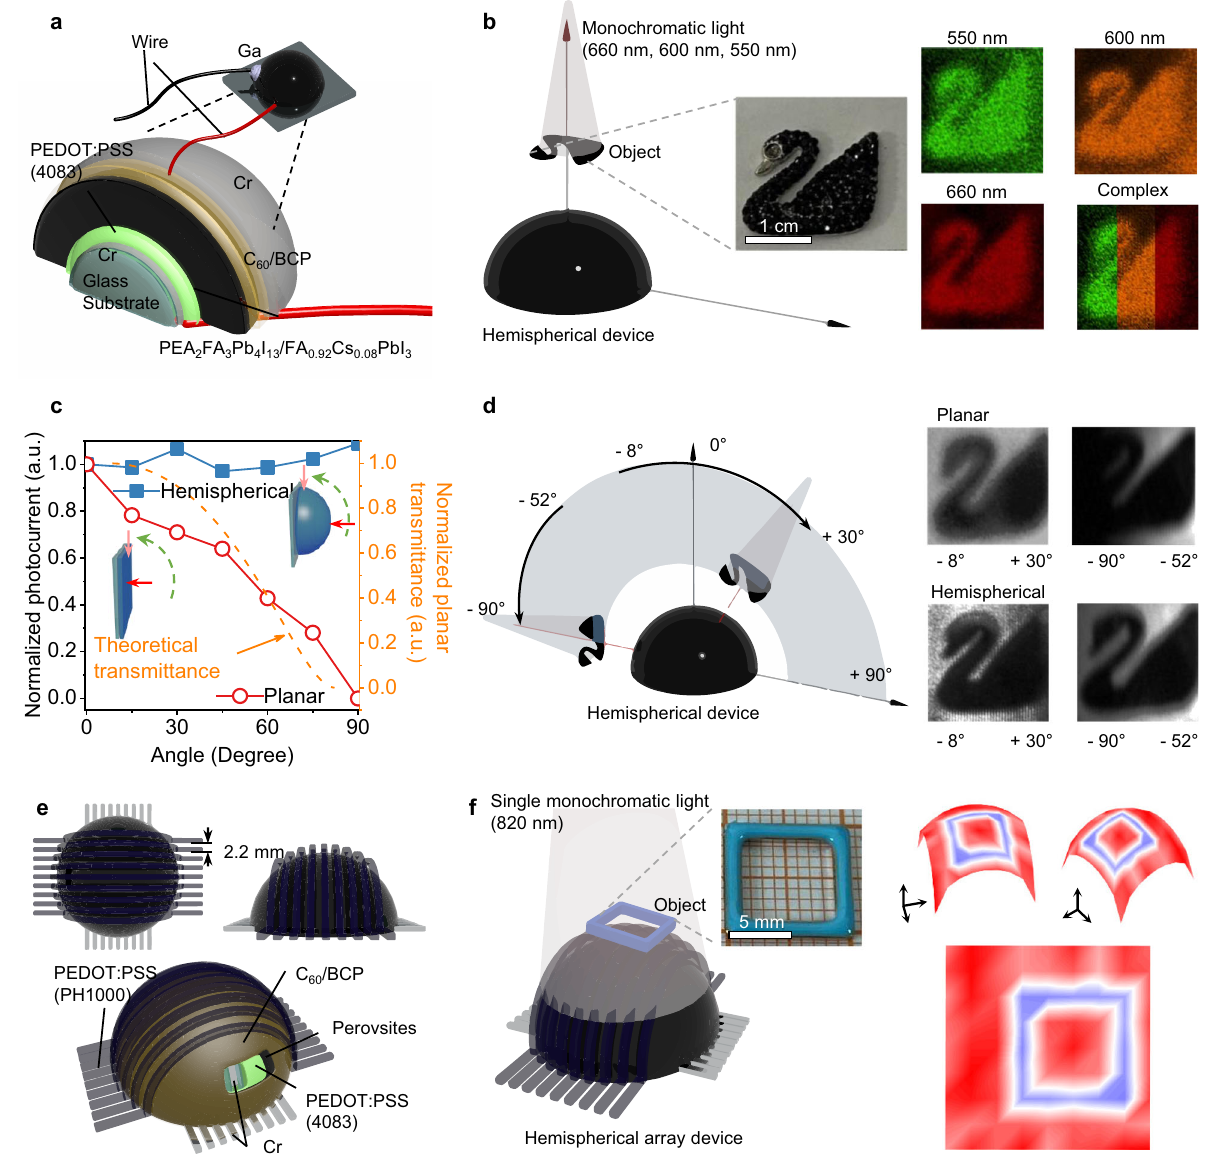
Fig. 4 | Narrow-band and Wide-angle imaging of a hemispherical photo- detector. a The device structure of the hemispherical photodetector. b Left: The schematic of the imaging system and the optical photo of a swan as object. Right: The images captured by hemispherical photodetectors with different I/Br ratios. The colors of images are matched to the color function. c The photocurrent of hemispherical photodetector under irradiation from different angles (The size of the light source is smaller than the area of photodetectors.). The orange line isthe